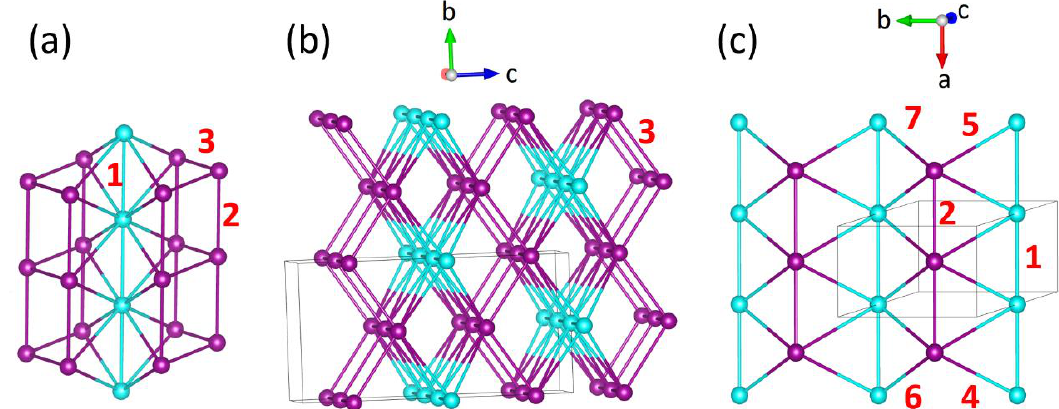
Figure 6. Arrangement of the Mn 2+ (cyan) and Mn 3+ (violet) ions in Ba 2 Mn 3 (SeO 3 ) 6 , where the numbers 1–7 refer to the exchange paths J 1 – J 7 , respectively: ( a ) Spin exchange paths between the Mn 2+ /Mn 3+ ions that are bridged by the SeO 3 groups in one hexagonal prism of Mn 3+ ions with one chain of Mn 2+ ions. ( b ) Projection view showing how chains of Mn 3+ ions interact with those of Mn 2+ ions. ( c ) Spin exchange paths J 4 – J 7 between the Mn 2+ and Mn 3+ ions.